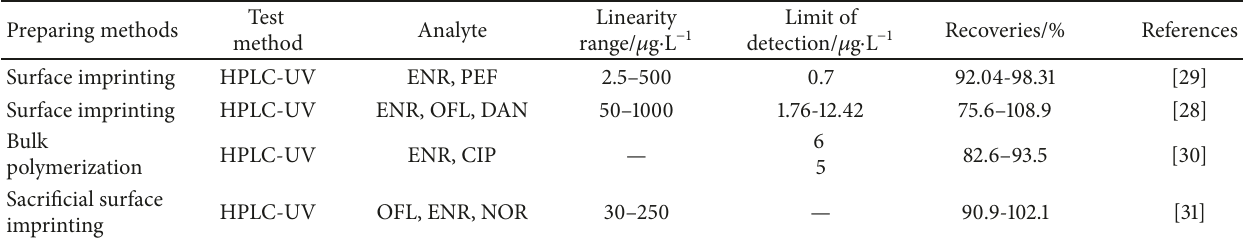
Table 6: Comparison of the ENR-MIPs applied for milk samples’ TCs detection with existing